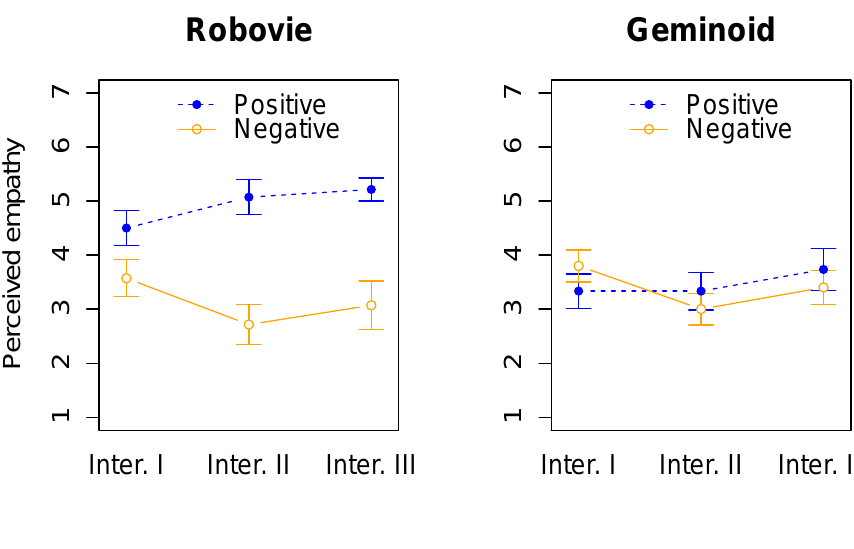
Figure 4: Mean perceived empathy with 95% confidence intervals measured in each interaction round (Interaction I, II and III) for positive and negative behaviour of both robots. Higher scores indicate higher perceived empathy of a robot.